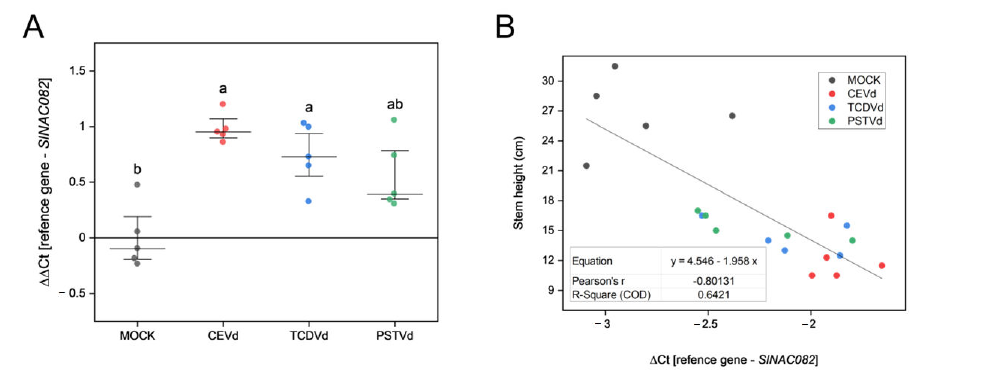
Figure 5. Induction of the ribosomal stress marker SlNAC082 is related to the severity of the symptoms. ( A ) Real-time PCR analysis of SlNAC082 expression in agro-inoculated plants with mock, CEVd, TCDVd, and PSTVd at 25 dpi. Expression levels are relative to tomato mock plants and normalized to the tomato actin gene. Data correspond to five independent plants ± SE. Data were analyzed using a Mann–Whitney test and different letters indicate significant differences ( p ≤ 0.05). ( B ) Correlation value and equation between the relative induction of SlNAC082 and the decrease in stem length in viroid-inoculated tomato